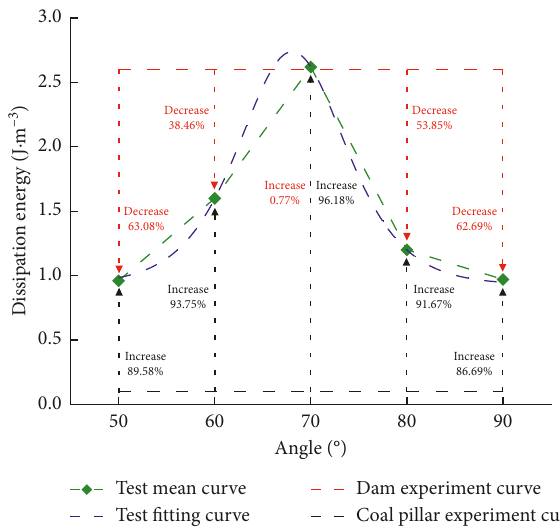
Figure 14: Relationship between angle and dissipated